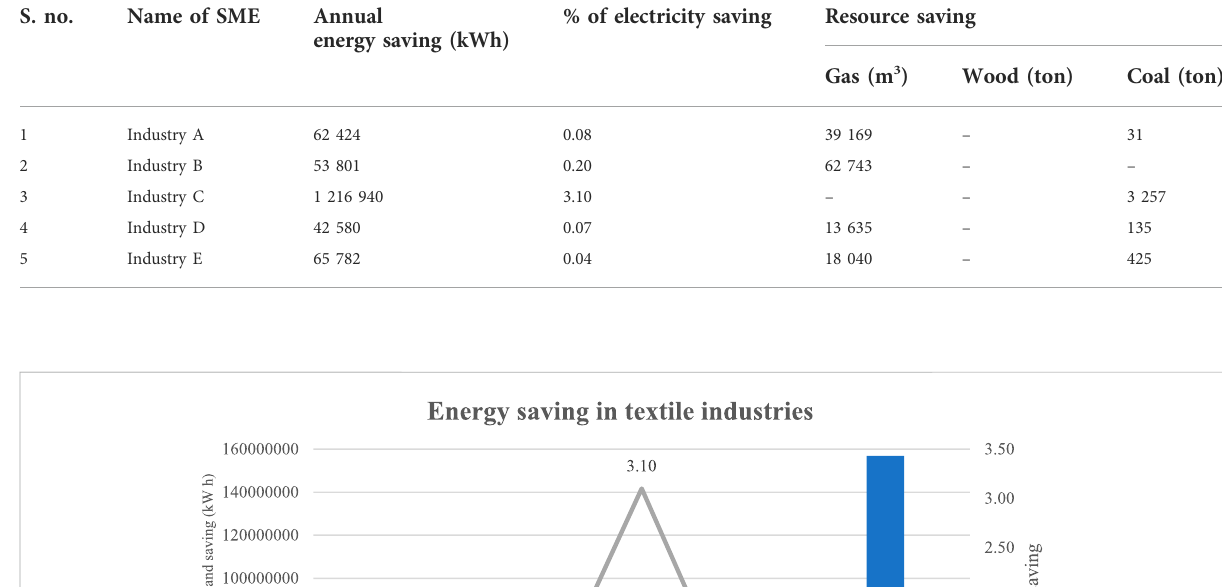
TABLE 7 Volume fraction of energy conservation (%) by textile industries.